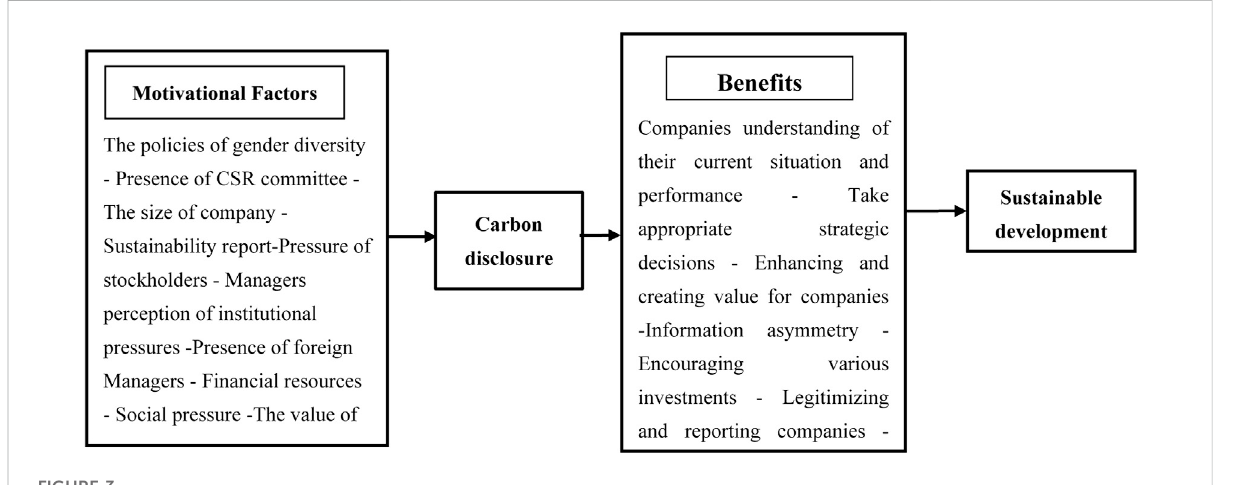
FIGURE 3 Factors that motivate carbon disclosure and bene fi